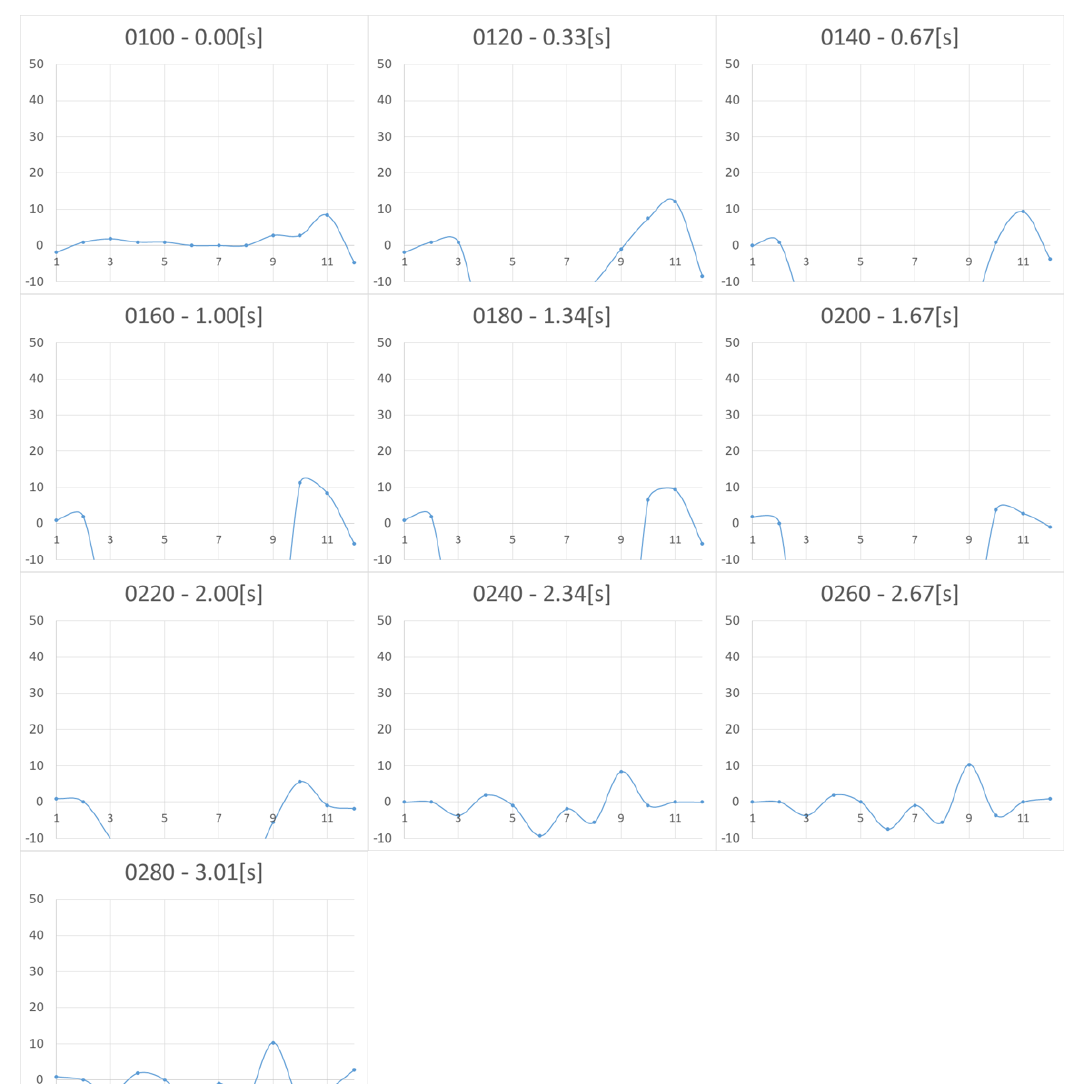
Figure 5. Change in pressure distribution for Nattō (2D view, longitudinal section of the center). The vertical axis represents the force (in milli Newton). The horizontal axis represents the location of the sensing point. The four-digit numbers in each graph show the frame numbers at the time of measurement. Measurements were taken in 0.0165 s/frame (60 fps).